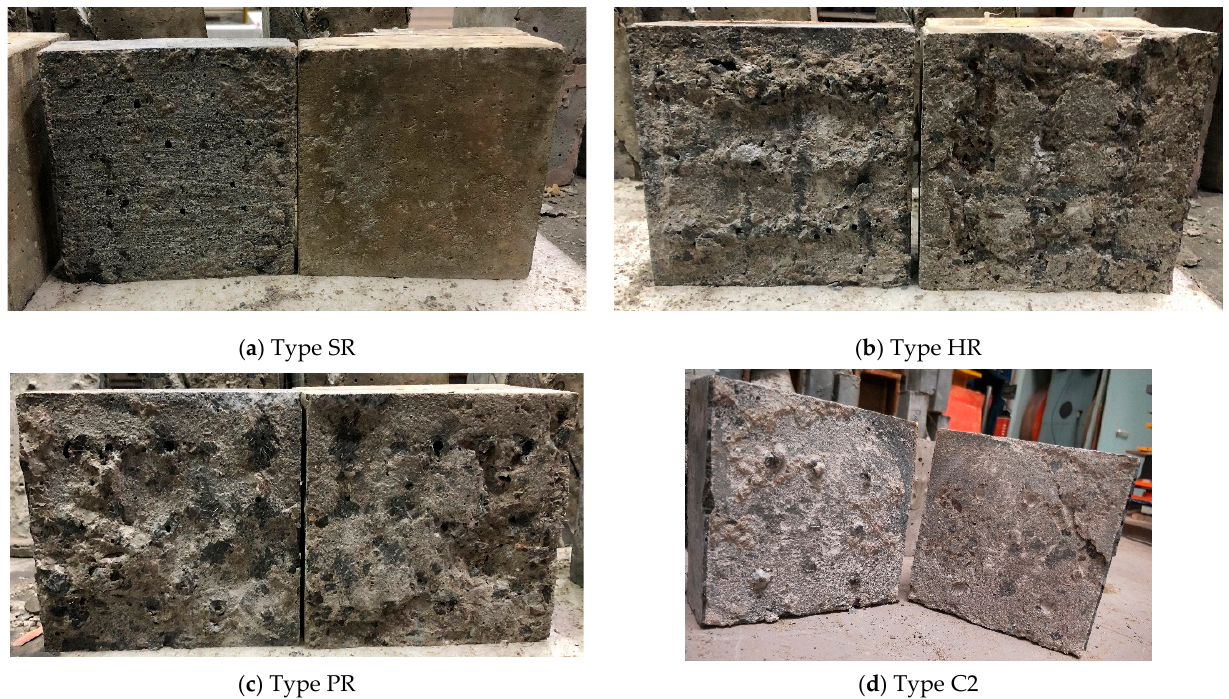
Figure 10. Failed interfaces with di ff erent interface processing methods.